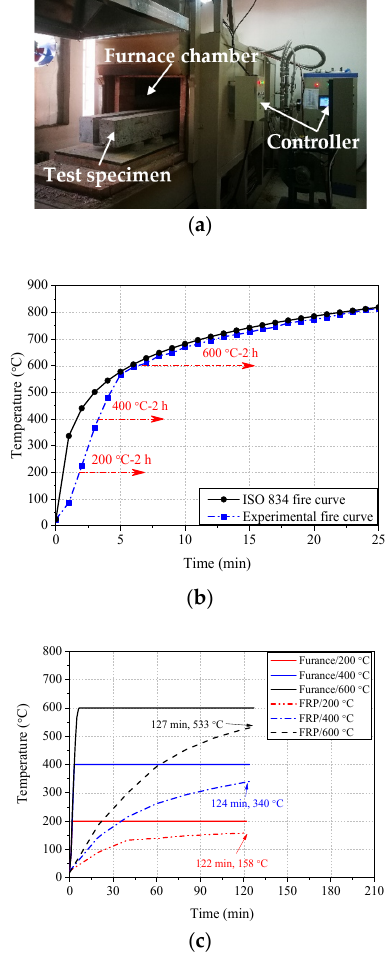
Figure 3. Heating system for test beams: ( a ) furnace; ( b ) heating scheme for test specimens; ( c ) measured temperature at the location of FRP bars.